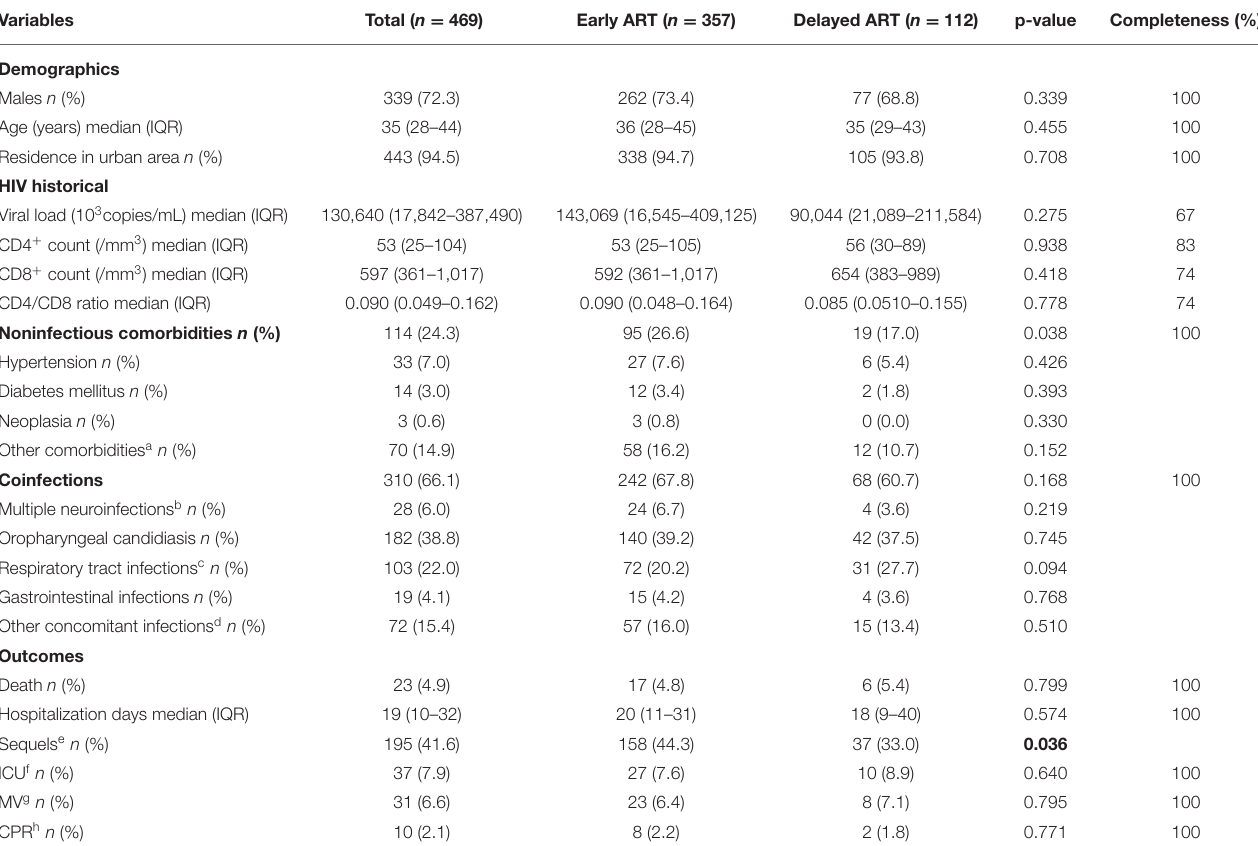
TABLE 1 | Baseline characteristics and outcome according to ART initiation